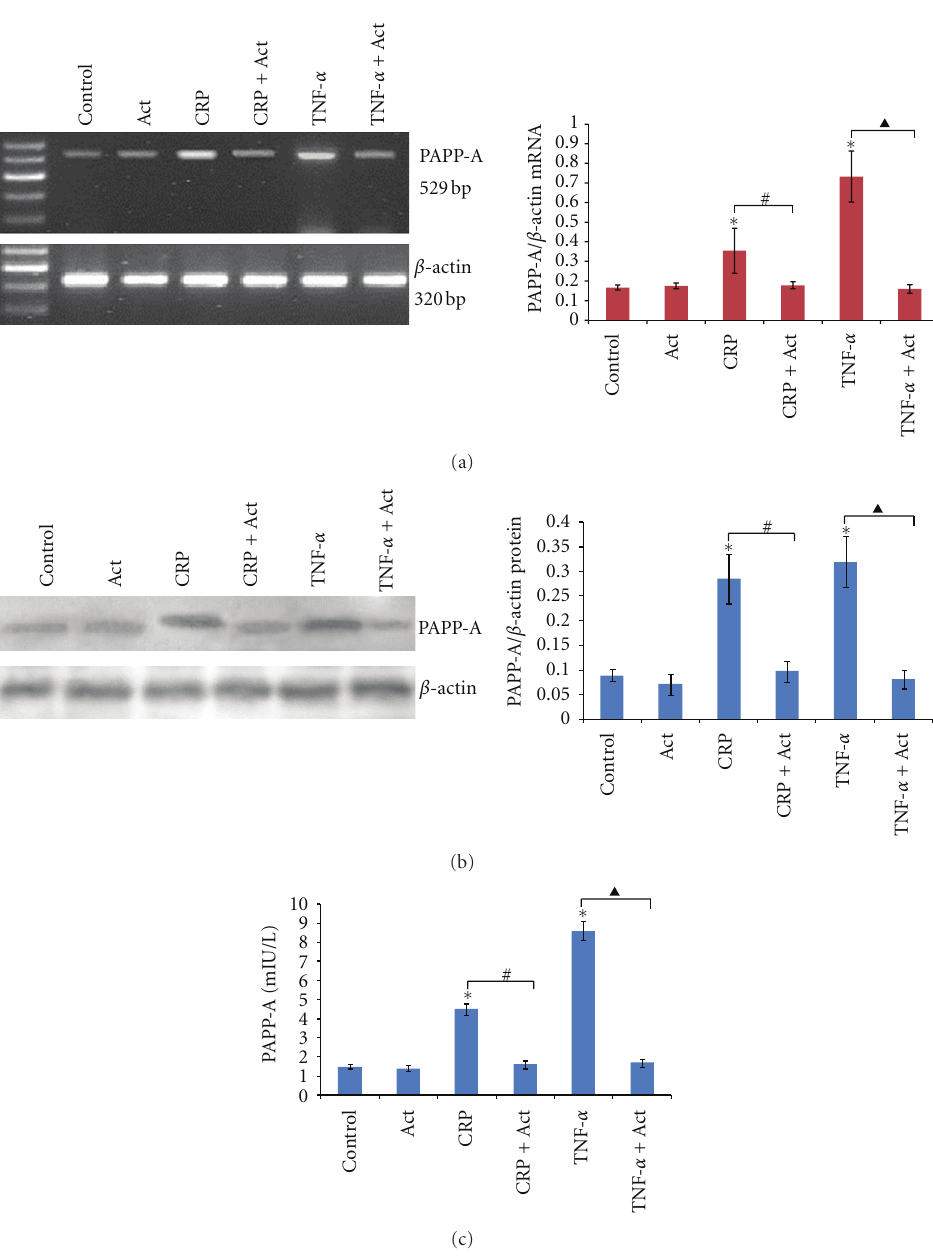
Figure 3: Regulation of PAPP-A expression: e ff ects of actinomycin D. PBMCs were treated with or without (control) 20mg/L CRP or 100ng/mL TNF- α in the absence or presence of actinomycin D (1 μ g/mL). RT-PCR was performed on RNA, (a) Western blotting was performed on cell lysates, (b) and an ultrasensitive ELISA was performed on conditioned medium (c) after 8 h treatment. The results are expressed as the means ± SD of six donors. ∗ : P < 0 . 05 compared with the control; #: P < 0 . 05 the CRP group versus the CRP + Act group; (cid:2) : P < 0 . 05 the TNF- α group versus the TNF- α + Act